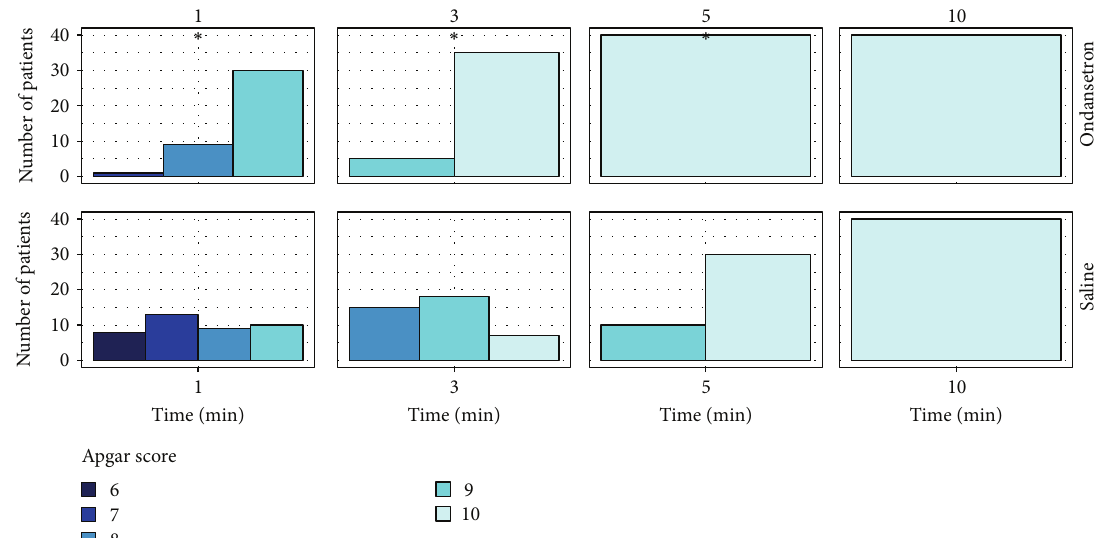
Figure 7: Apgar score of newborns during 1, 3, 5, and 10 minutes after birth. ∗ < 0.05